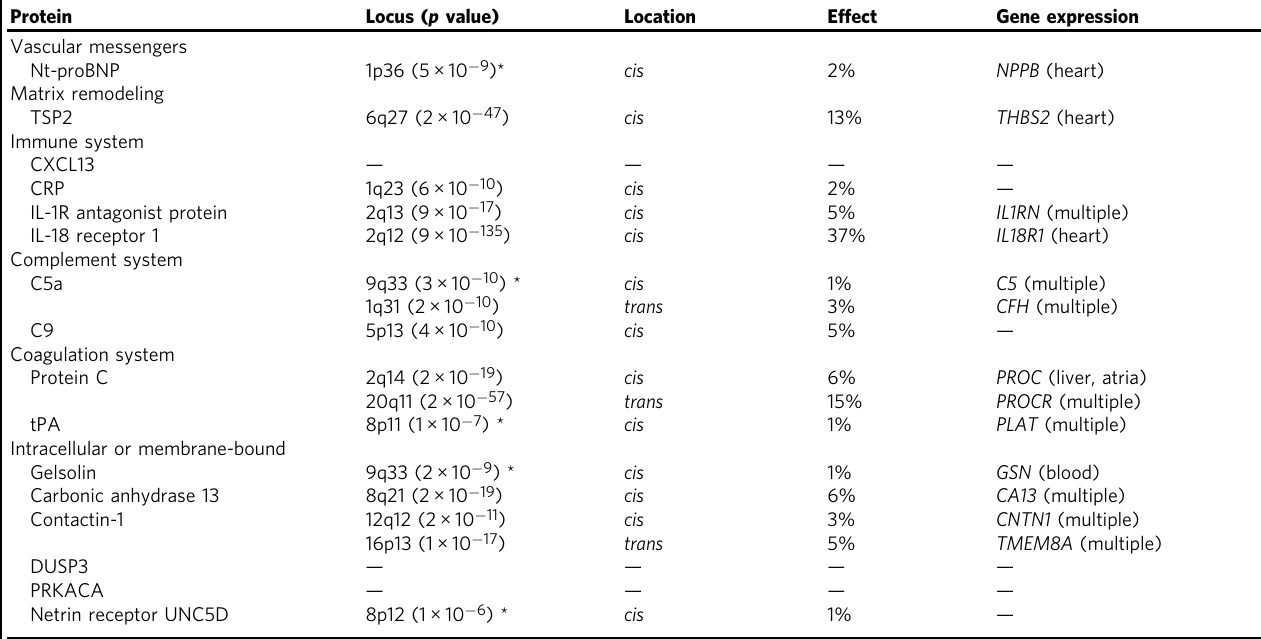
Table 4 Genetic associations with plasma